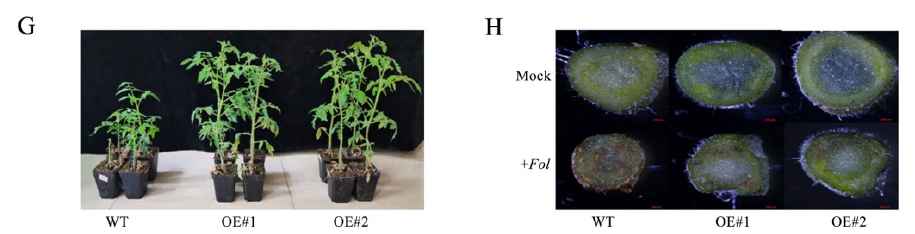
Figure 5. Effects of SlNAP1 overexpression on Fusarium wilt resistance after Fol inoculation. ( A – D ) Phenotypic symptoms (plant height, stem diameter, fresh weight and dry weight) of plants at 21dpi after Fol inoculation; ( E ) photosynthetic parameters of overexpressed plants; ( F ) transcript abundance of SlNAP1 gene in transgenic plants; ( G , H ) plant phenotype and stem cross section at 21 dpi. Different letters (a, b, c, d, and e) indicate statistically significant differences at p = 0.05 lev- el.